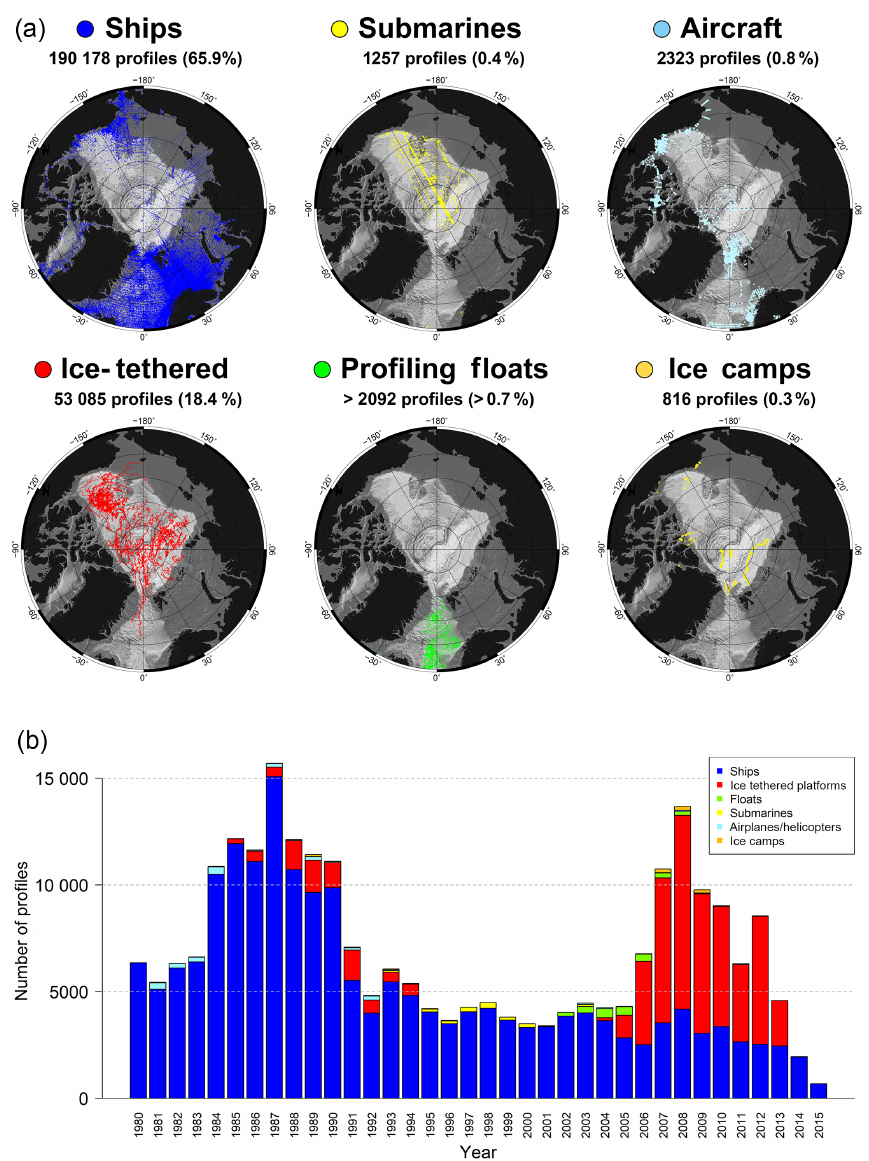
Figure 12. (a) Distribution maps of different platform types. The fraction of the full data set is shown as percentage in brackets behind the respective number of profiles. The two maps on the right-hand side are associated to some extent, as some of the airplane and helicopter surveys started from ice camps. A large number of profiles (approximately 38000, not shown) could not be associated with a platform type in the first attempt (see text for details). (b) Number of profiles per year, measured from different platforms